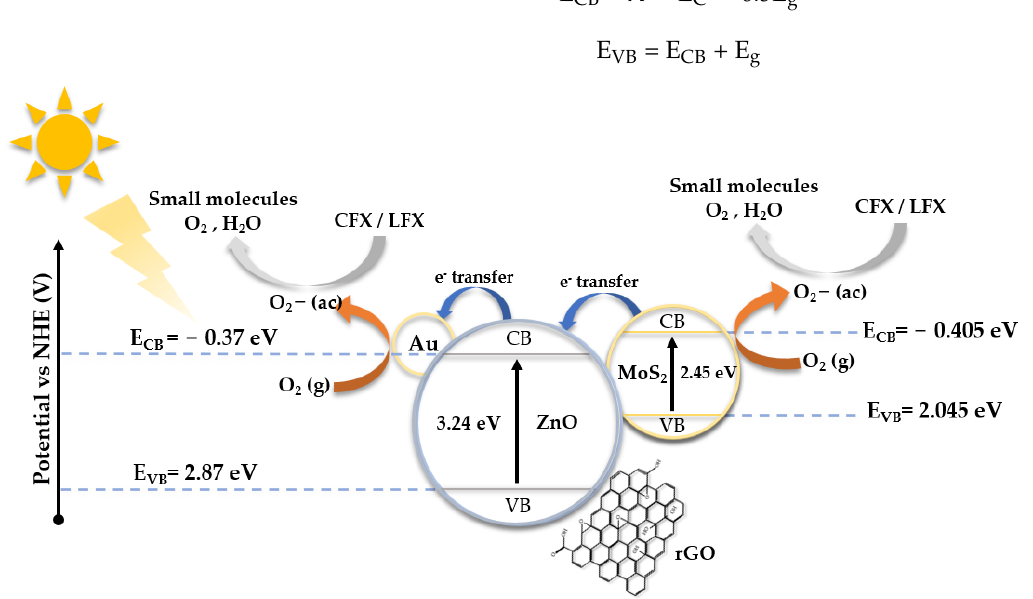
Figure 9. Schematic diagram of the proposed mechanism for CFX and LFX photodegradation using Au@ZnONPs-MoS 2 -rGO catalysts under visible irradiation. In the context of visible light, photons lack the necessary energy to extract an electron from the valence band (VB) of ZnO. Consequently, the mechanism for degradation pre- dominantly depends on the other constituents of the system. On the other hand, under the same conditions, MoS 2 has the capability to liberate electrons from its VB to the con- duction band (CB) through visible light irradiation. The resultant electrons possess suffi- cient energy to reduce oxygen (O 2 ) molecules, generating superoxide radicals ( • O 2 − ) that subsequently react with water to produce hydroxyl radicals. These hydroxyl and super- oxide radicals can facilitate the oxidative degradation of LFX and CFX. Due to the more negative edge potential of the conduction band (E CB ) of MoS 2 ( − 0.405 eV) relative to Au@ZnONPs ( − 0.37 eV), photoinduced electrons from the VB of MoS 2 can be introduced into the CB of Au@ZnONPs. Once inside, O 2 can seize these electrons to create • O 2 − and hydroxyl radicals, which can oxidize and decompose antibiotics. Numerous investiga- tions [62 – 64] have documented that gold nanoparticles (AuNPs) can serve as electron sinks, thus mitigating e - /h + recombination and providing sites for catalytic reactions. As demonstrated in Figure S7, the incorporation of AuNPs leads to a significant decrease in photoluminescence, corroborating this observation. Another advantage of using AuNPs is that under visible light (~580 nm depending on the AuNPs' particle size) the phenome- non of surface plasmon resonance (SPR) occurs [62 – 64]. The SPR provides photoexcited electrons with enough energy to reduce the O 2 molecules to • O 2 − radicals. The bandgap of reduced graphene oxide (rGO) is determined to be 2.0 eV, as indicated in Figure 6. This characteristic permits the utilization of visible light to generate h + and photoexcited elec- trons, which can subsequently produce superoxide and hydroxyl radicals. Furthermore, the high surface area of rGO facilitates the creation of active sites conducive to the photo- catalytic process. The impacts of distinct nanostructured components on the catalyst ’ s be- havior was assessed through photoluminescence (PL) analysis. Figure S7 depicts the PL spectra of ZnONPs, 5%Au@ZnONPs, and the full catalyst (5%Au@ZnONPs-3%MoS 2 - 1%rGO). The PL spectra exhibit a wide emission peak with a maximum centered at ca. 546 nm upon excitation at 340 nm. The maximal PL emission intensity is observed in ZnONPs, which decreases upon the incorporation of 5%AuNPs (Figure S7b). The complete catalyst,